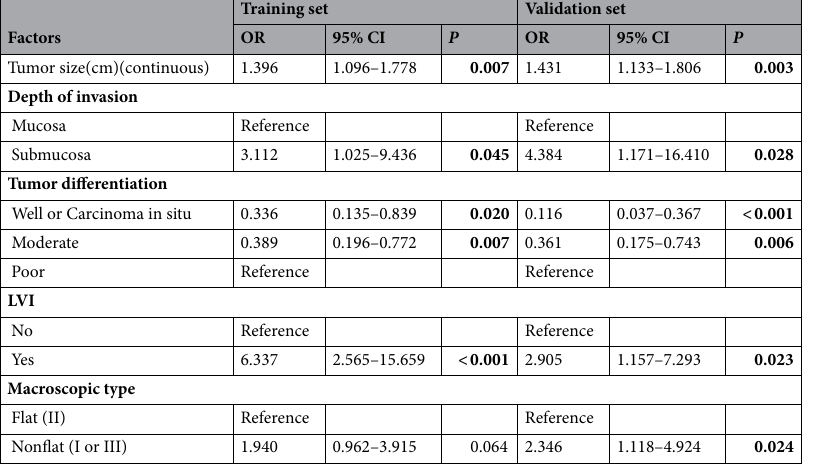
Table 3. Multivariate logistic analysis of risk factors for lymph node metastasis in training and validation sets. The bold values mean statistical significance. LVI, lymphovascular invasion; I = superficial and protruding type; II = flat type; III = superficial and excavated type.